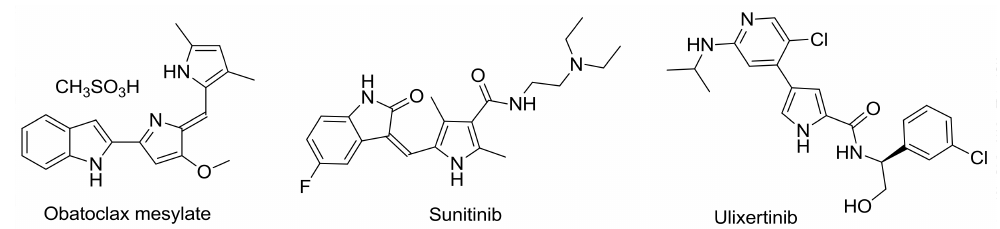
Figure 1. The structures of obatoclax mesylate, sunitinib, and ulixertinib.